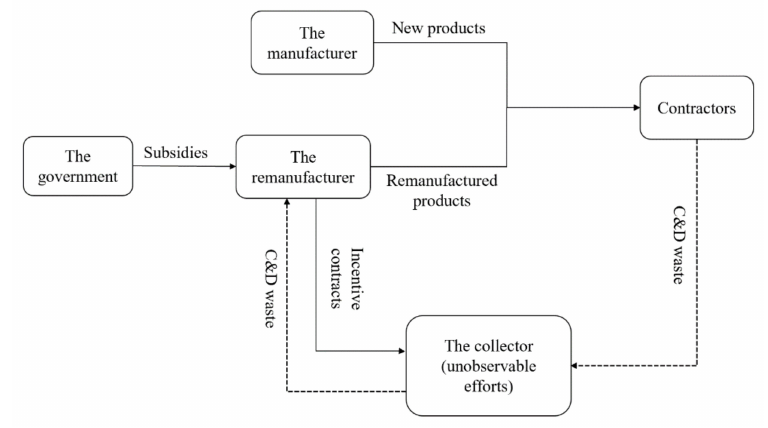
Figure 1. Process flow chart of the construction and demolition (C&D) waste recycling procedure.